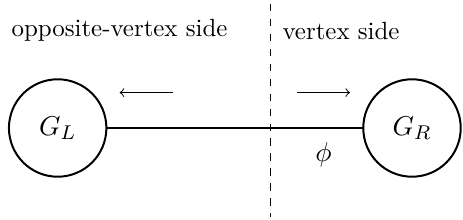
including the edge L